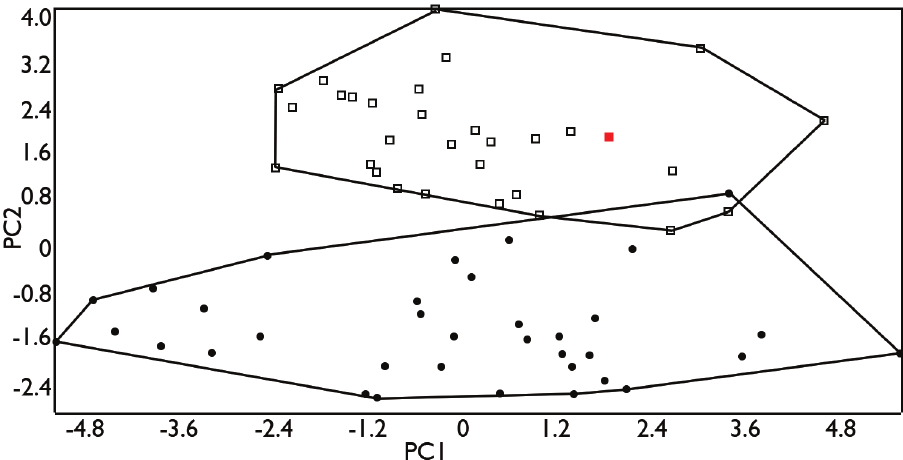
Figure 3. Ordination diagram of principal components 1 and 2 from the PCA of morphological data for females. Circles represent specimens from the Atlantic versant; squares represent specimens from the Yucatan Peninsula. The red square indicates the syntype of Anolis ustus . Table 3. The Own Root and Explained Variance of canonical function 1 for female morphological data obtained with GDA. Only statistically significant morphological variables according to Wilks’s Lambda test are presented. * p <